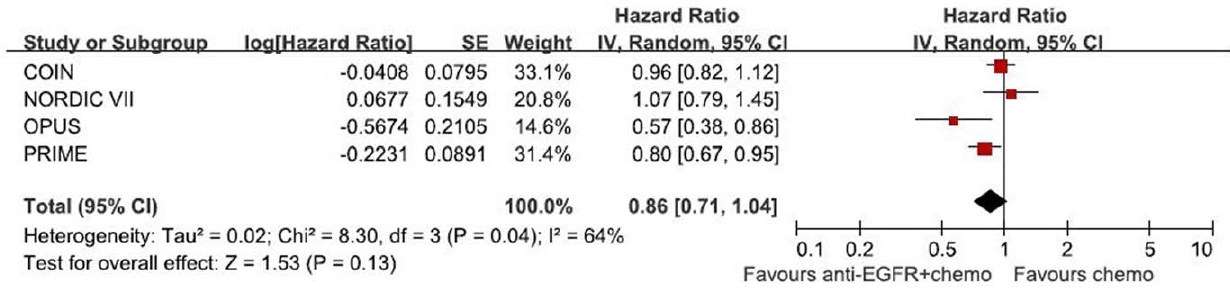
Figure 3. Randomized effect model on HR of PFS. The pooled HR of PFS is symbolized by a solid diamond at the bottom of the forest plot and the width of which represents the 95% CI.